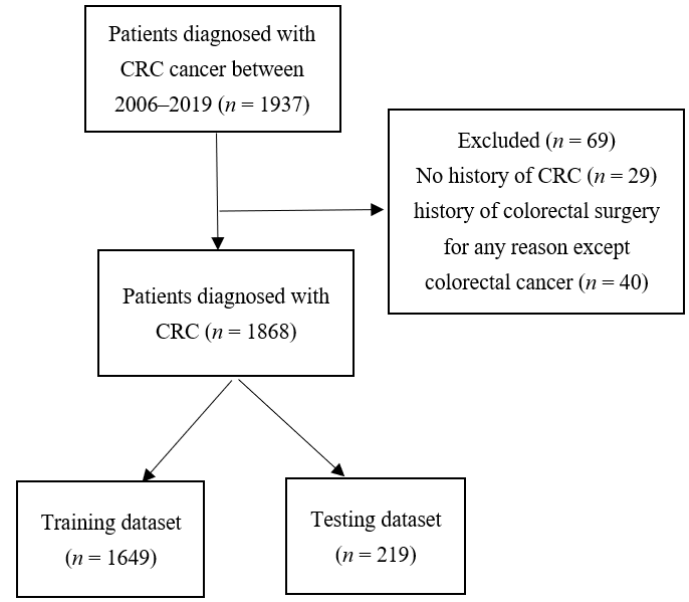
Figure 1. Flow chart of the patient selection process.